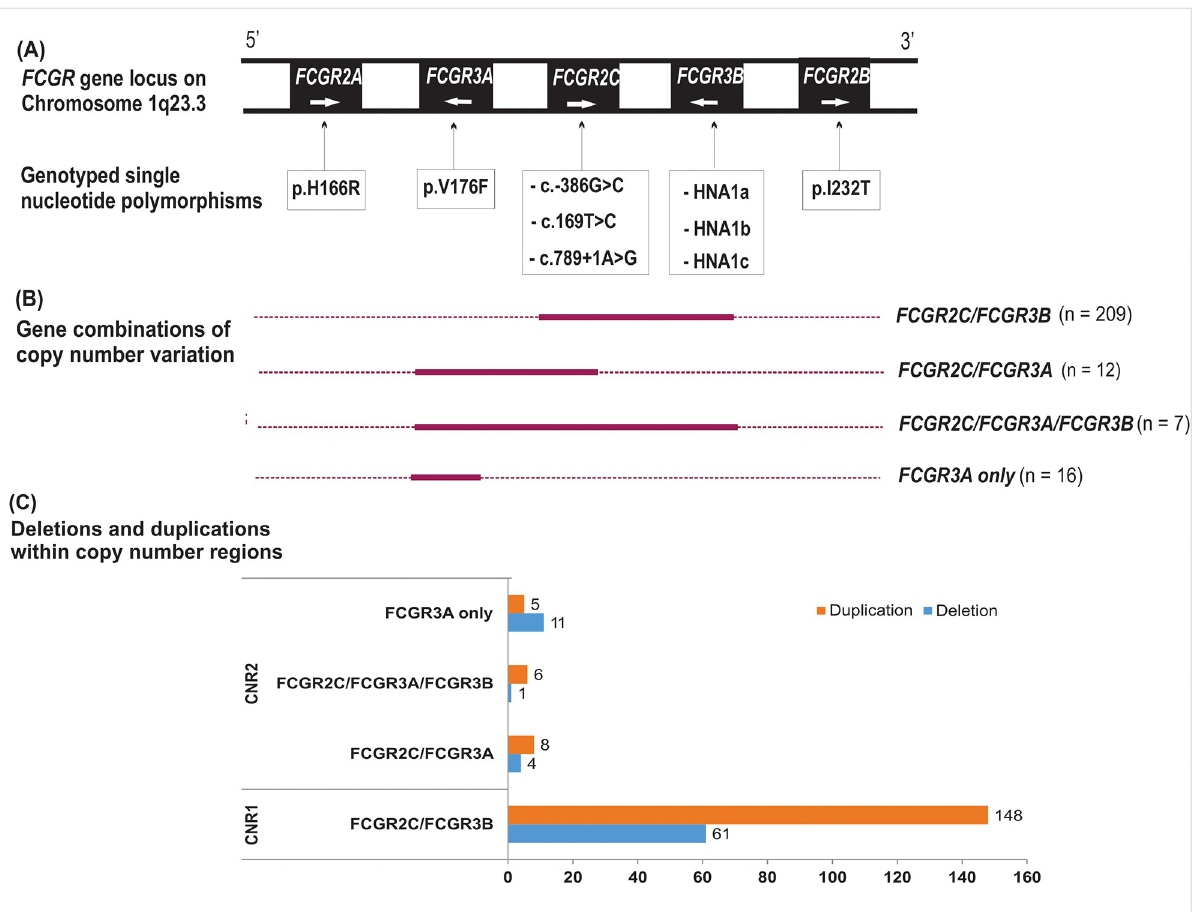
Fig 1. Diagrammatic representation of the FCGR2/3 locus structure and variation. (A) The FCGR2 and FCGR3 genes on human chromosome 1q23 with their orientation and the functional polymorphisms genotyped in the study. Polymorphic amino acids are indicated by one-letter code. (B) CNV has been previously described within distinct copy number variable regions (CNRs) [38, 39]. Four gene combinations of CNV, either duplication or deletion, were observed and are indicated as solid lines. The FCGR2C/FCGR3B and FCGR2C/FCGR3A combinations correspond to the previously designated CNR1 and CNR2, respectively. (C) Copy number region deletions and duplications within CNR1 and CNR2. This displays further breakdown of individuals with either a deletion or duplication within the 4 distinct gene combinations of